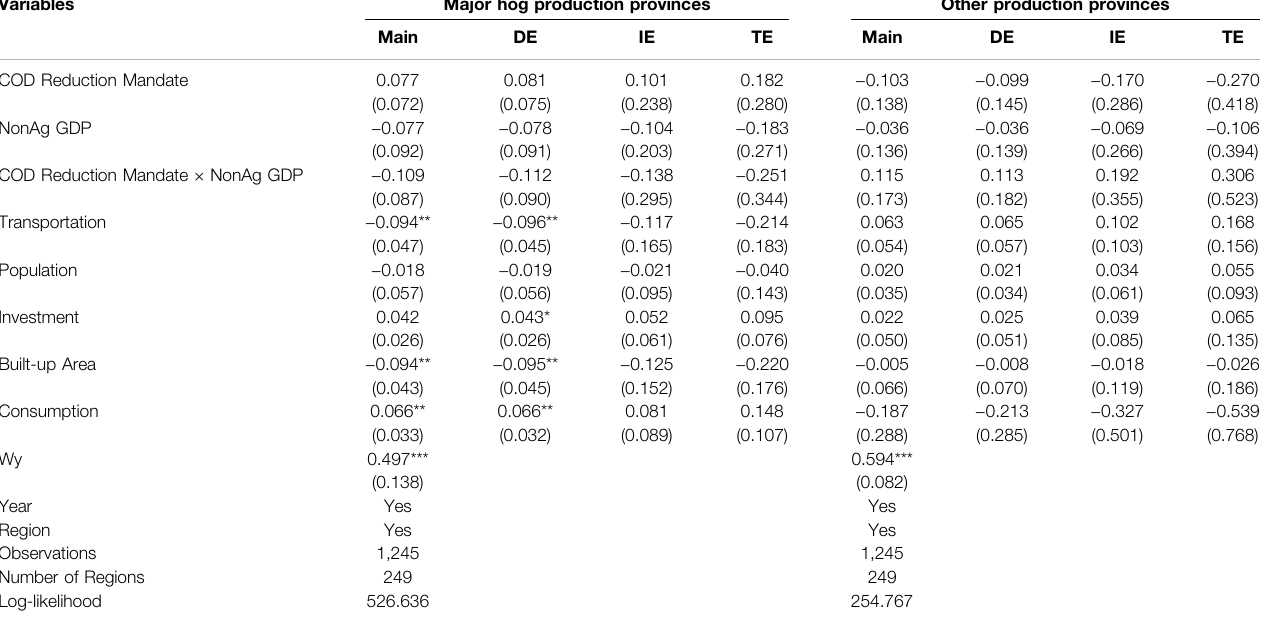
TABLE 4 | Heterogeneity test of 11th Five-Year Plan.